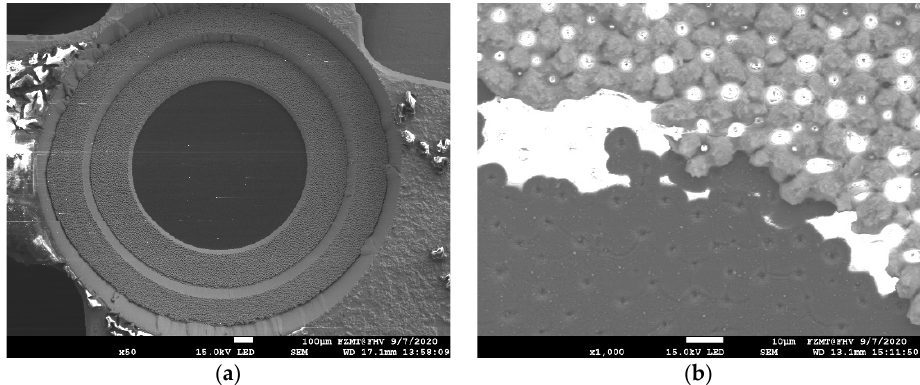
Figure 1. SEM micrograph of ( a ) 22 µm thick, laser-generated diamond membrane and ( b ) 1 µm notches in the diamond layer due to pinholes in